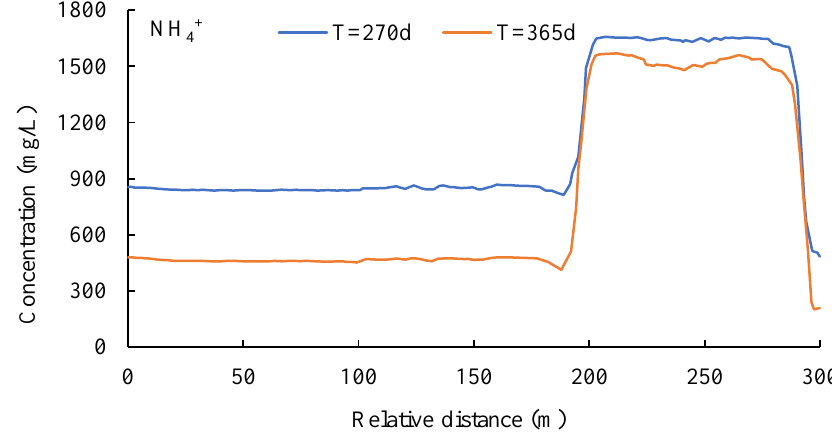
Figure 9. Horizontal distribution of NH 4+ at the 2.34 m depth below ground surface.